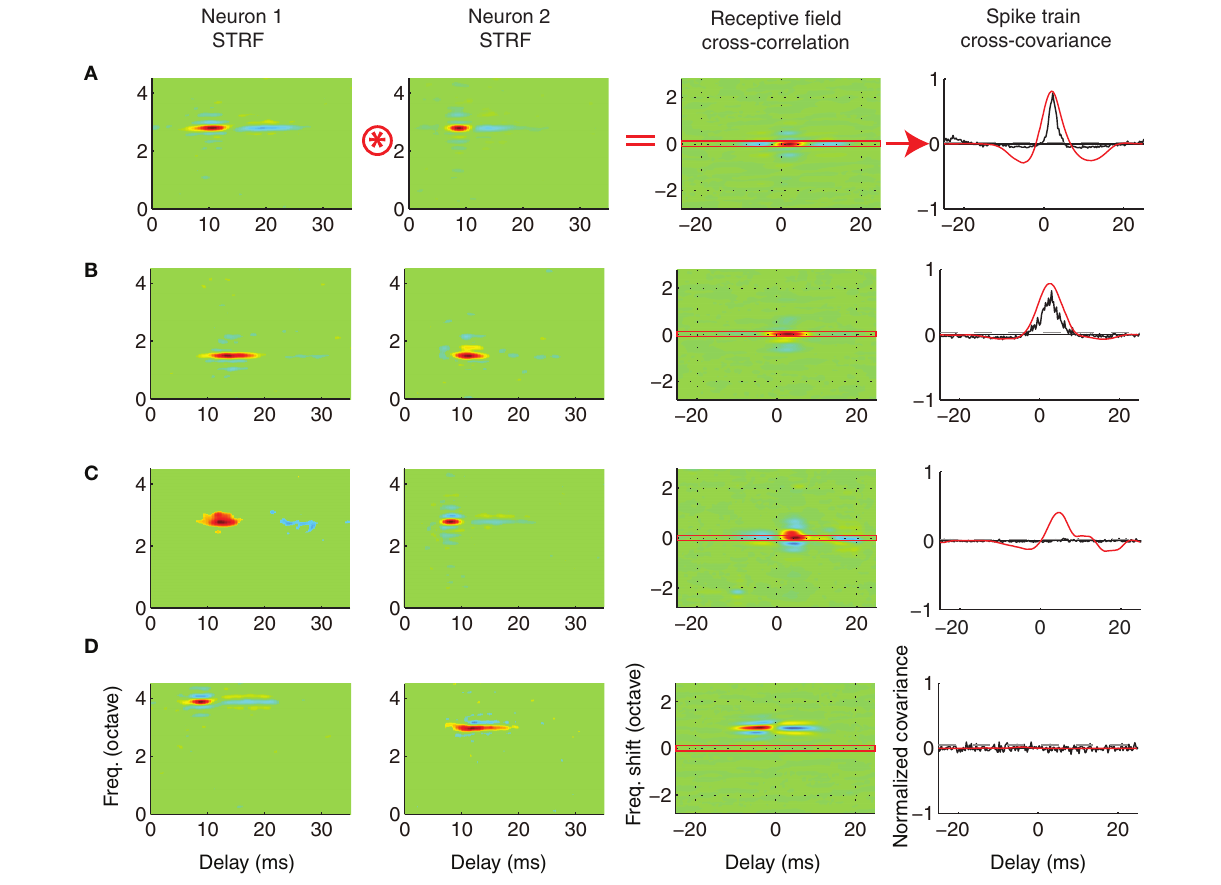
subsequently selecting the temporal cross-section about zero frequency shift (red horizontal section, in column 3; see Materials and Methods). For instance, the example neuron pairs of A and B have STRFs with similar structure and thus the RFCC shows a strong positive peak about zero frequency shift. The predicted spike train covariance mirrors the SCC for each pair (column 4, red ). In C , the neurons are highly overlapped in frequency, however, STRFs fail to predict the lack of correlation observed between the neural spike trains. The pair shown in D has receptive fields that are temporally delayed (neuron 1 leads neuron 2) and which differ in frequency by 1 octave. Because of the lack of frequency overlap the predicted ( red ) and measured SCC ( black ) are both